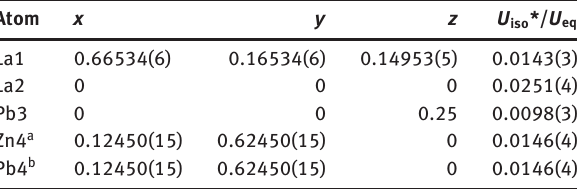
Table 2: Fractional atomic coordinates and isotropic or equivalent isotropic displacement parameters (Å 2